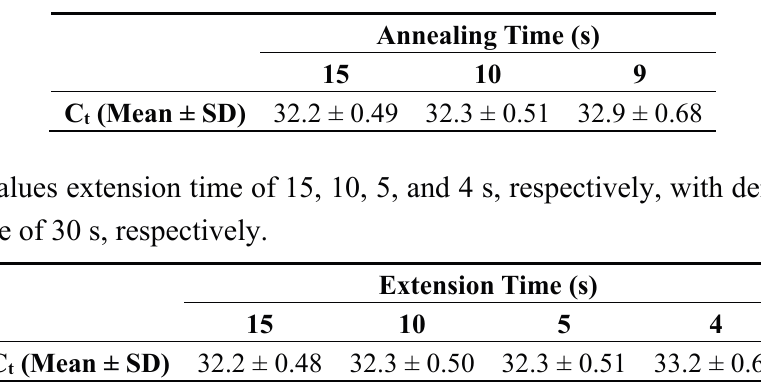
Table 2. C t values with annealing time of 15, 10, and 9 s, respectively, denaturation and extension time of 30 and 40 s, respectively.